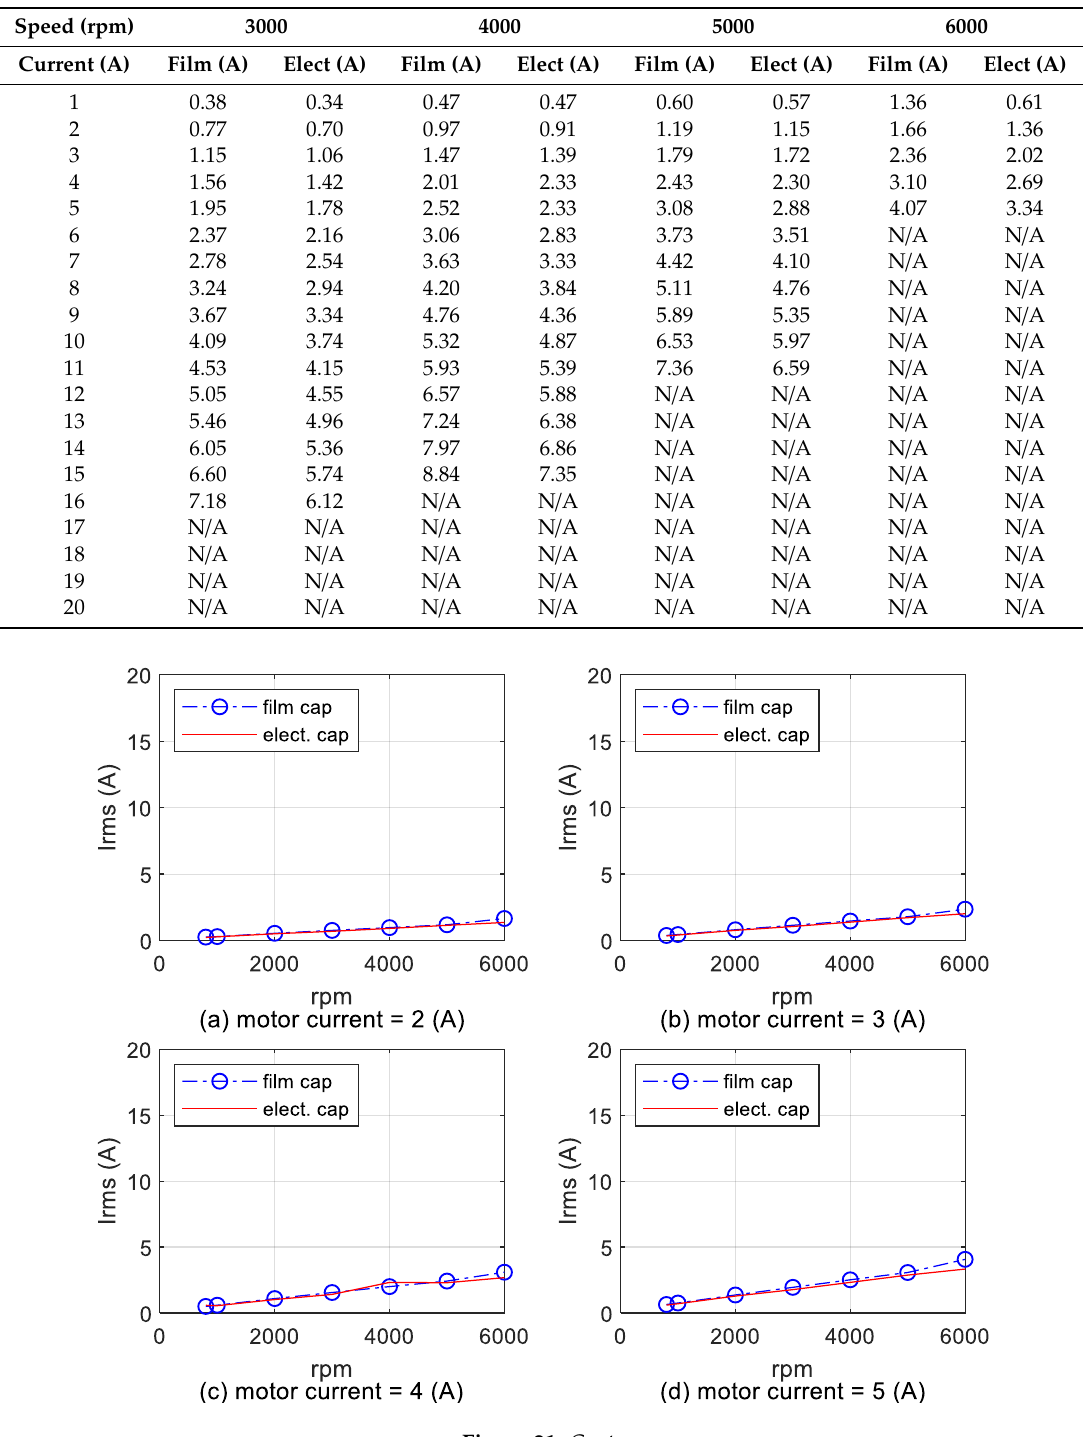
Table 5. Capacitor RMS current at a speed range of 3000–6000 rpm.